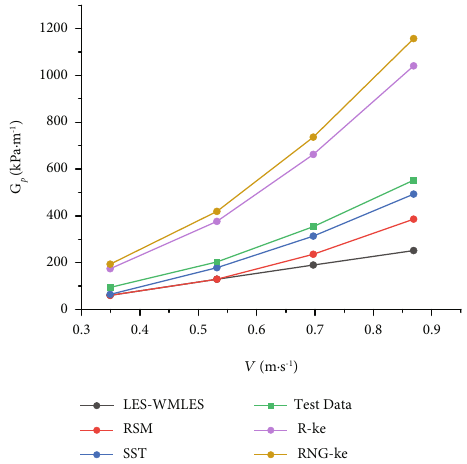
Figure 6: Comparison of simulation and test